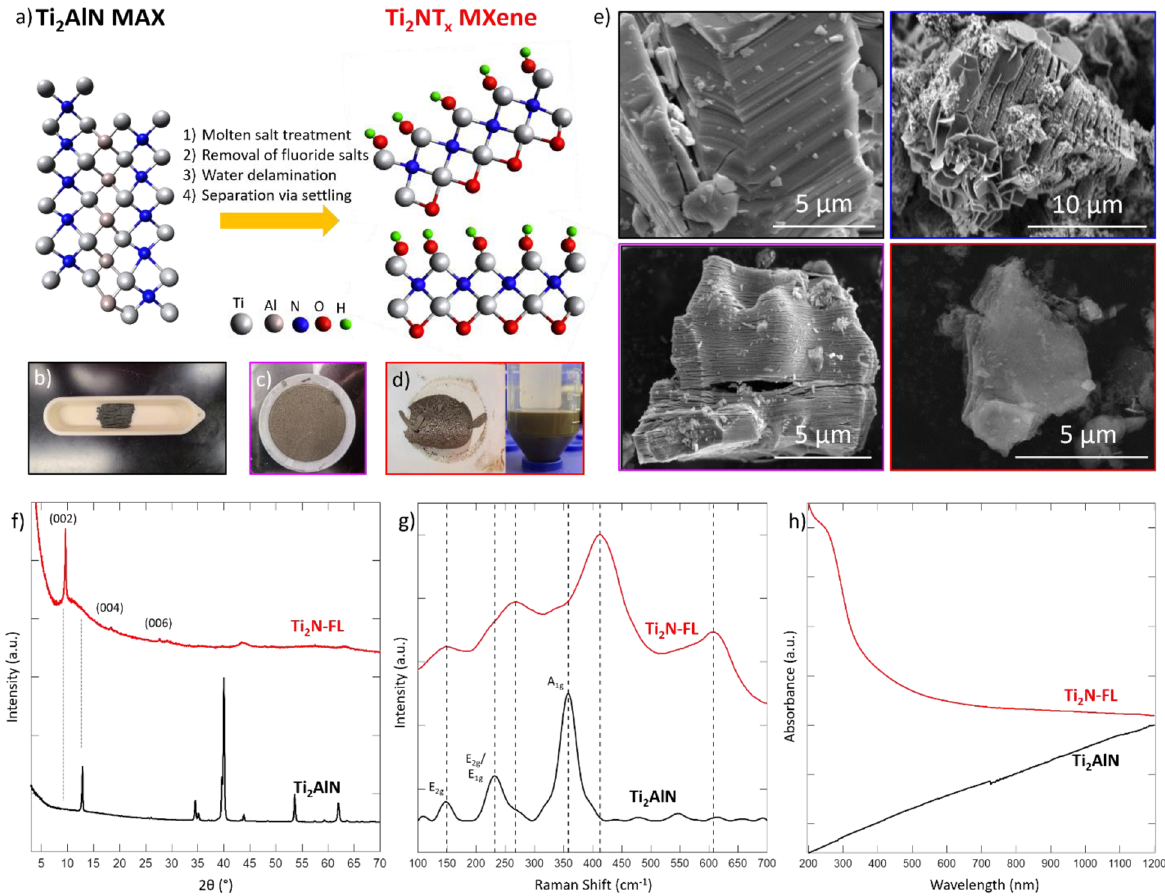
Figure 1. ( a ) Schematic illustration of the synthesis of Ti 2 NT x MXene via oxygen-assisted molten salt fluoride treatment of the parent MAX phase Ti 2 AlN at 550 °C for 5 h under flowing argon, then exposure to air, followed by fluoride salt removal in 4 M H 2 SO 4 , finally delamination is accomplished via sonication in water for 4 h. Models are not based on gathered data, only as a general guideline. In lab photographs of ( b ) MAX phase, ( c ) Multilayer Ti 2 N MXene after acid washing, and ( d ) Single layer MXene acquired after delamination in water. ( e ) SEM imaging of Ti 2 AlN MAX phase (black outline), molten salt treated MAX phase (blue outline), multilayer Ti 2 N MXene (purple outline), and few layer Ti 2 N MXene (red outline). The lateral size of the individual MXene flakes is roughly 5 μm. ( f ) XRD, ( g ) Raman, and ( h ) UV–Vis spectra of Ti 2 AlN MAX phase (black) and single layer Ti 2 N MXene (red). XRD was gathered using a zero-diffraction silicon plate with a well. Raman spectroscopy was gathered using 532 nm laser at 5% power at a 1 s exposure time. UV–Vis spectroscopy was collected using water as the